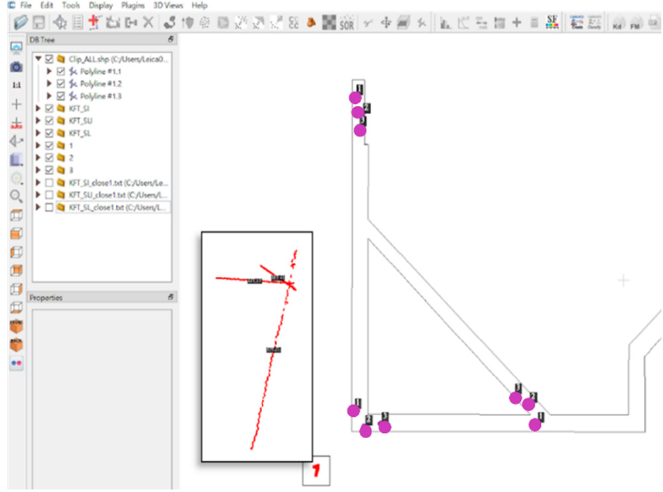
Figure 7. Schematic of key frames and matching points.